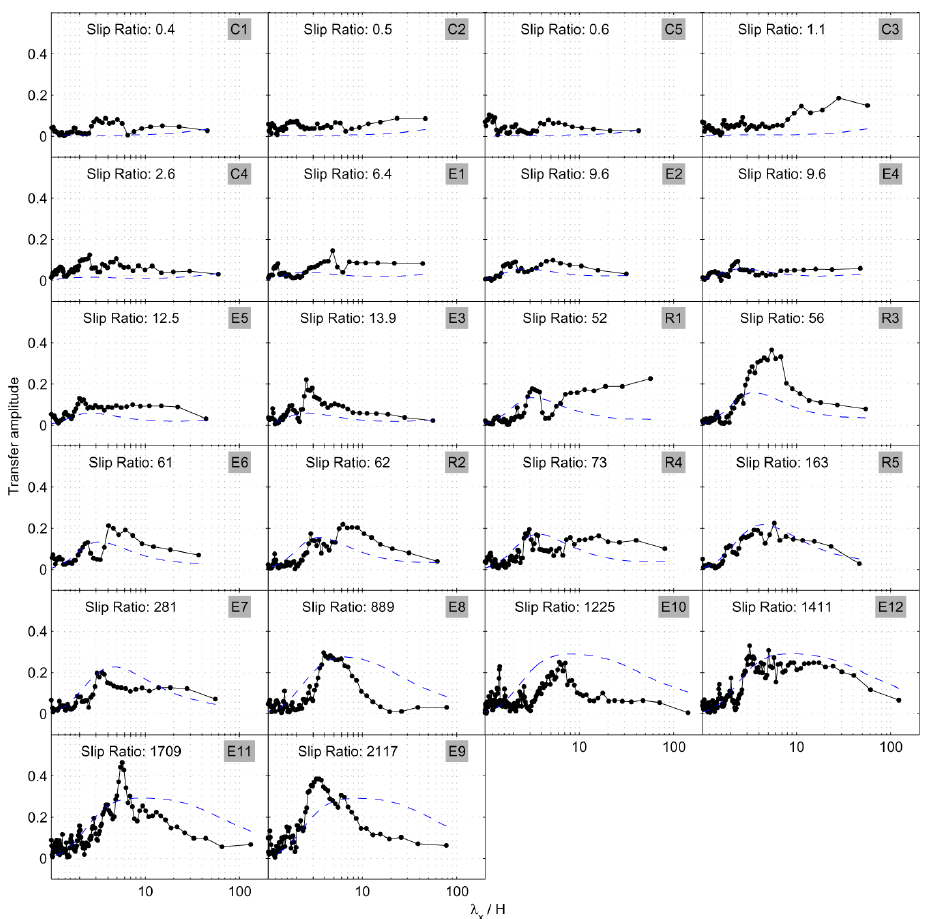
Fig. 4. Estimated transfer amplitudes for radar profiles along the Carlson Inlet (C1–C5), Rutford Ice Stream (R1–R5) and Evans Ice Stream (E1–E12), ranked from low to high values of the slip ratio. The dashed blue lines show the corresponding flow-line prediction, scaled by a factor f = 0 . 3 in order to account for three-dimensional effects. The value of f was obtained from an optimal least-square fit with the